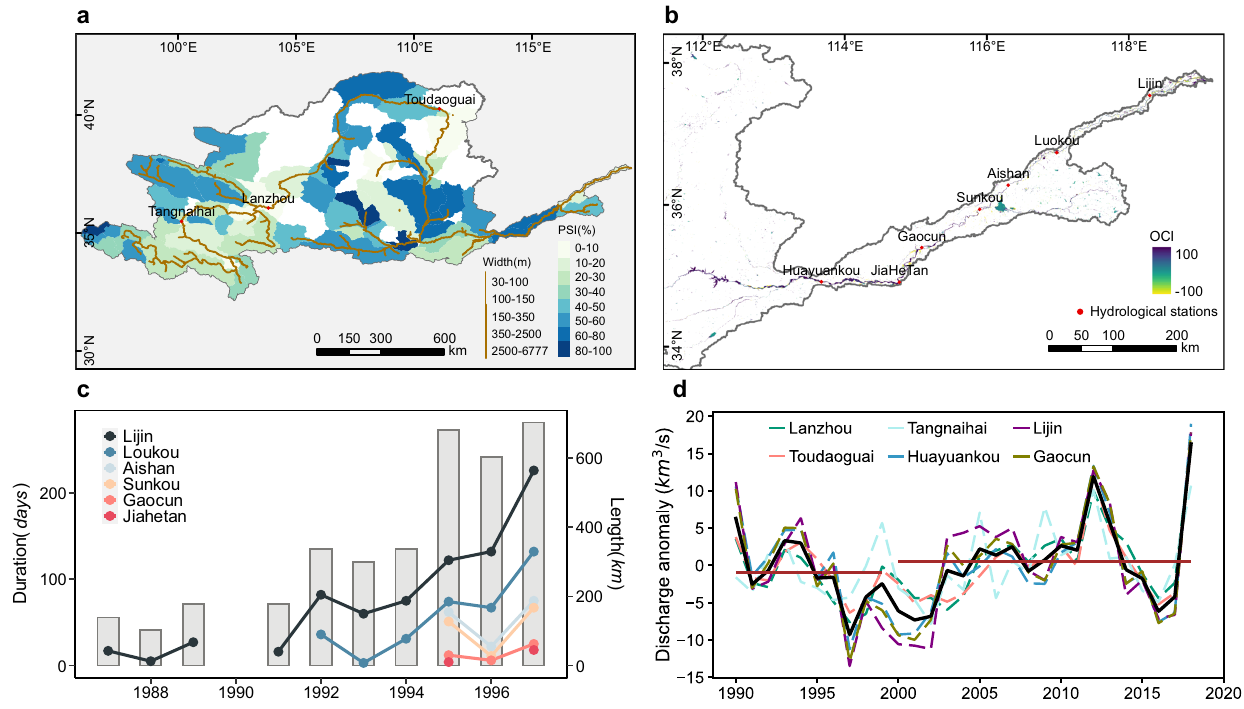
Fig. 7 | Flow cutoff and recovery in the Yellow River. a The percentage of sig- ni fi cant increase class in the Yellow River basin. b The OCI map on the lower reaches. The distribution of gauging stations is shown in red dots in the maps of a , b . c The dried-up distance and duration (no available data in 1984 – 1986 and